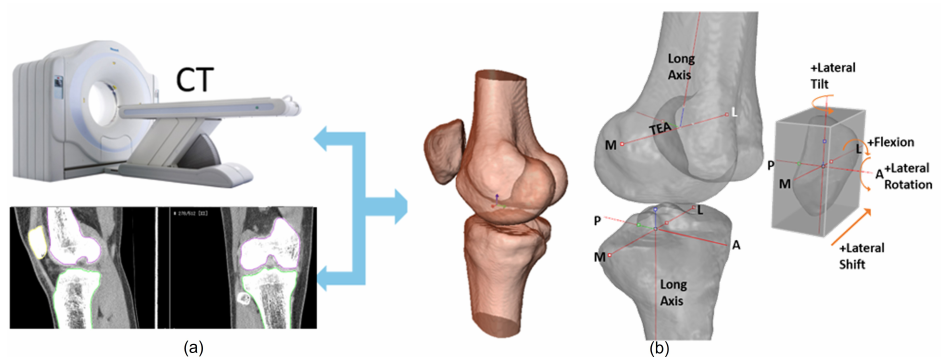
Figure 2. ( a ) Creation of 3D knee bone templates from a series of CT scans captured in the knee extension position. ( b ) Definition of the coordinate systems of the femur, the tibia, and the patella used to quantify the patellar tracking parameters and tibiofemoral joint angle: M, medial; L, lateral; A, anterior; P, posterior; TEA, trans-epicondylar axis.